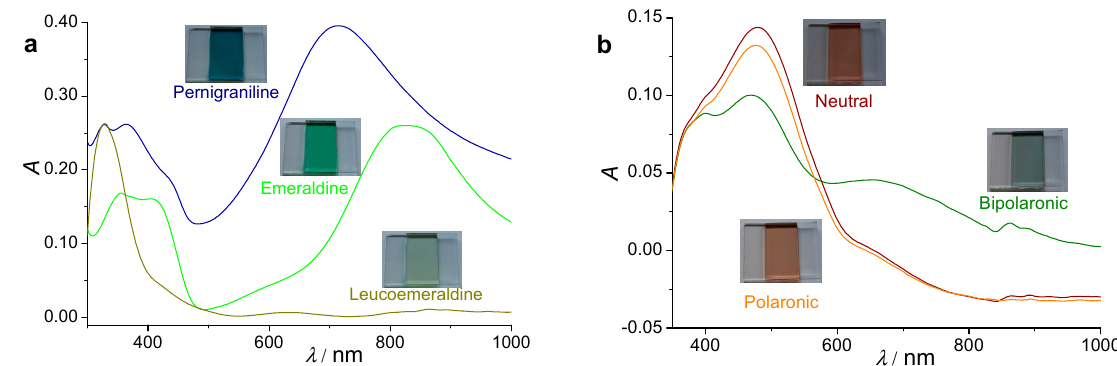
Figure 3. Absorption spectra and photographic images of electrochromic devices based on ( a ) PANI and ( b ) PBTh at different doped levels.